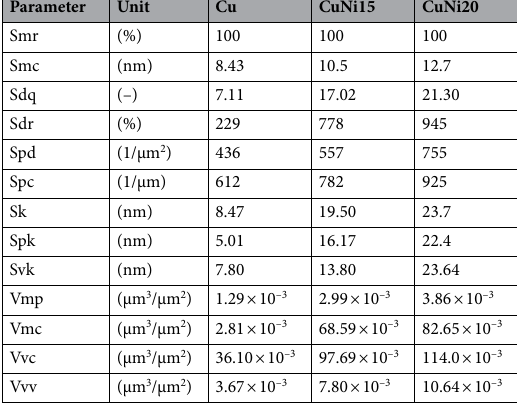
Table 3. ISO surface parameters were obtained from the AFM topographical maps of the